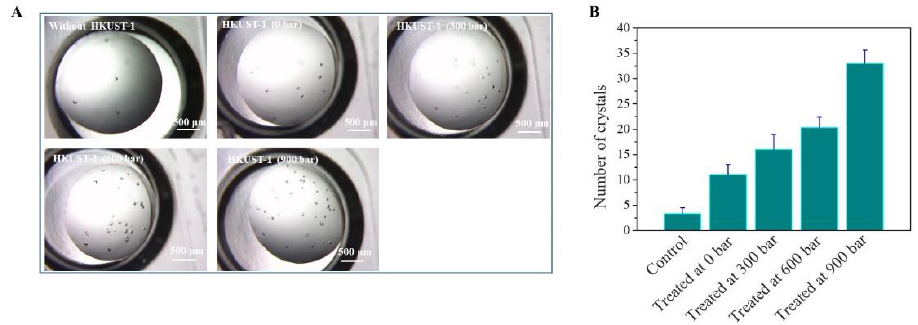
Figure 3. ( A ) Protein crystallization trials of lysozyme at a final concentration of 10 mg · mL − 1 in presence of different treated HKUST-1, lysozyme control (top left), 0 bar (top middle), 300 bar (top right), 600 bar (bottom left), and 900 bar (bottom right) of nano-sized HKUST-1. ( B ) Nucleation density (number of crystals/drop) of lysozyme upon HKUST-1 under different treatments. The concentration of HKUST-1 is 0.1 mg · mL − 1